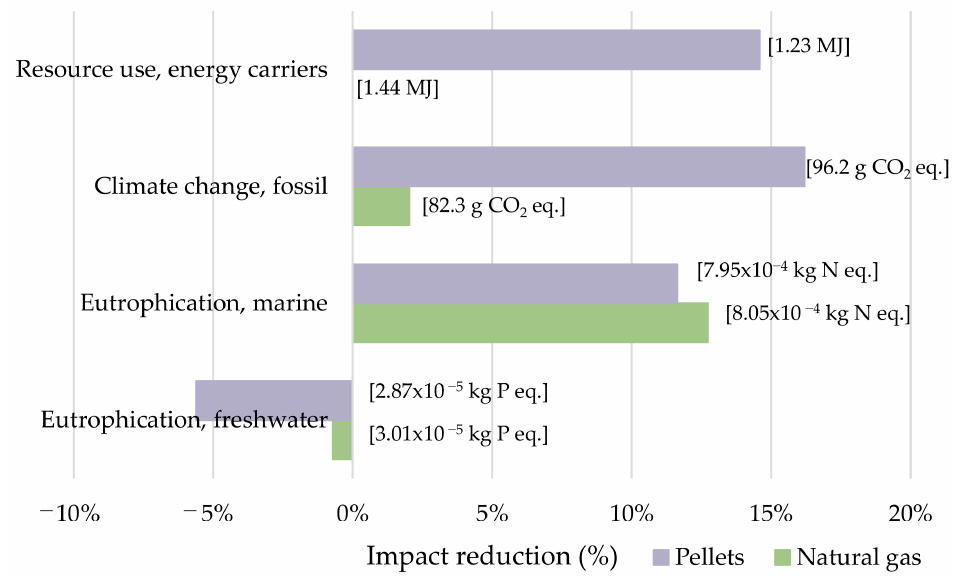
Figure 7. Reductions in water and energy-related indicators considering alternative energy resources for frying. Values between brackets represent total impacts per